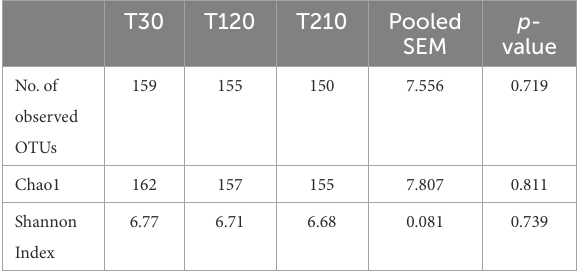
TABLE 8 Alpha-diversity indices of fecal microbiota of obese dogs ( n = 16) before (T30), after 90 days (T120), and at the end (T210) of caloric restriction (phase 2 of the